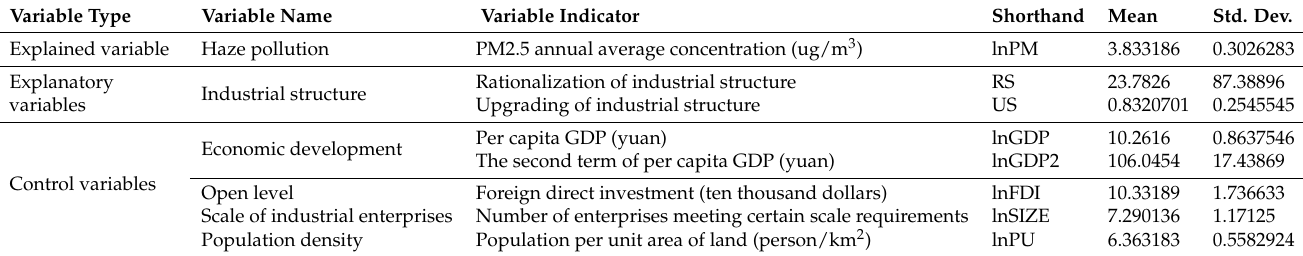
Table 2. Variable